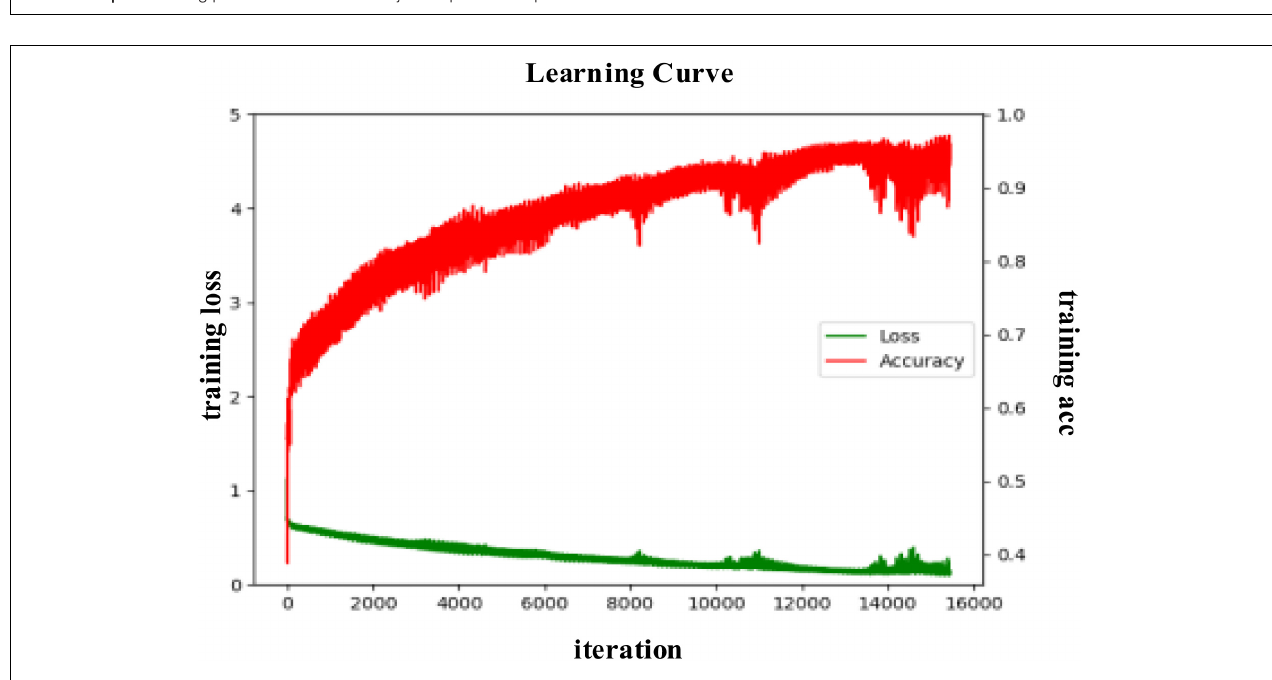
FIGURE 8 | The training process curve in the subject-dependent experiment in arousal.